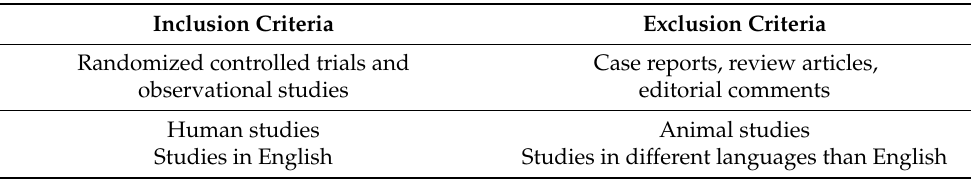
Table 1. Inclusion and exclusion criteria for the systematic